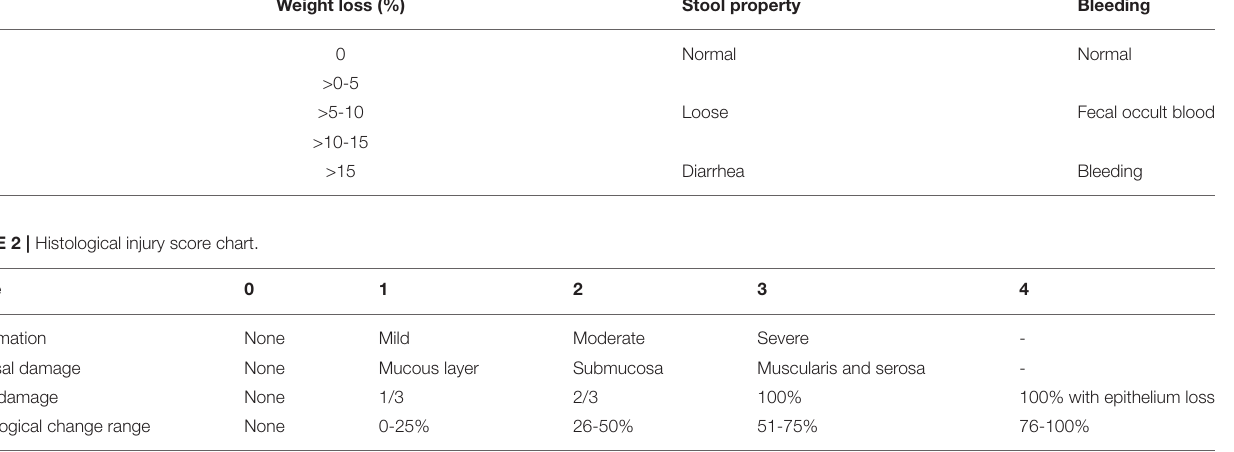
TABLE 1 | Disease activity index (DAI) score chart.